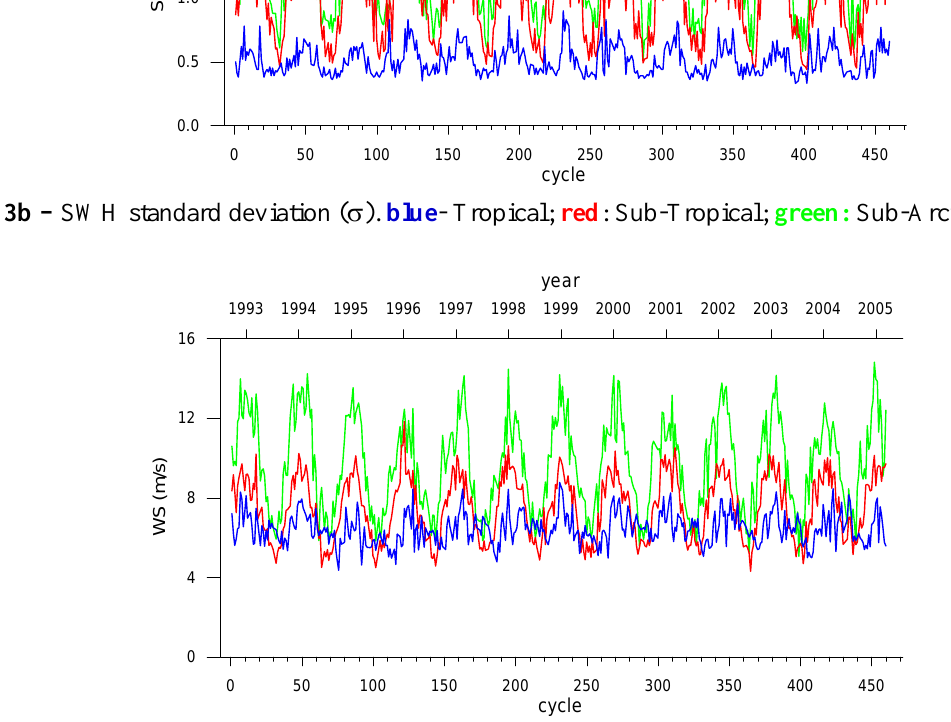
Figure 14a – Average WS. blue - Tropical; red : Sub-Tropical; green: